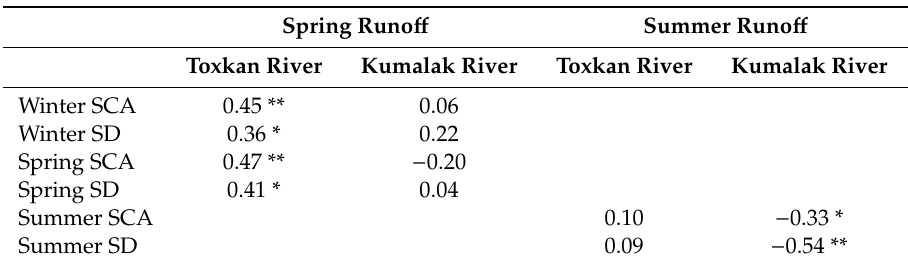
Table 4. Seasonal correlation coe ffi cients between SCA, SD, and runo ff in the Toxkan River and Kumalak River from 1979–2015.